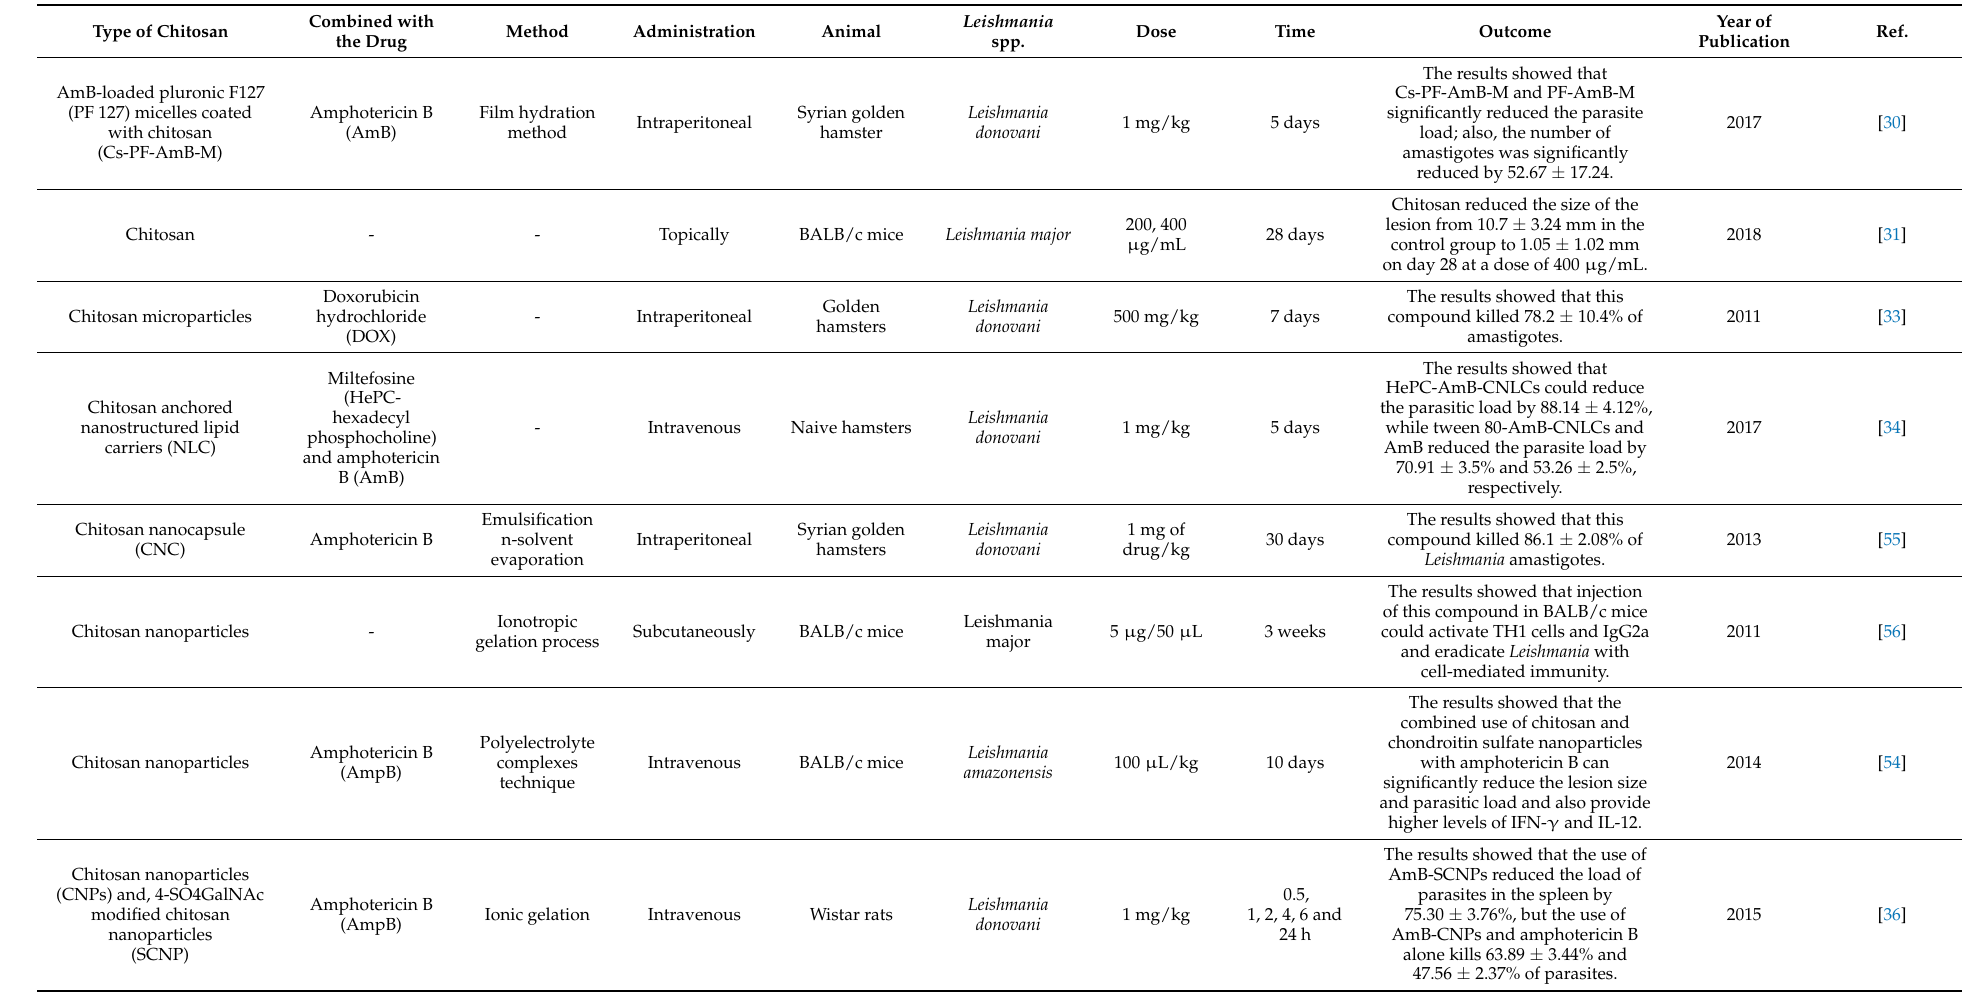
Table 2. A list of in vivo studies of chitosan and its derivatives as resources for anti-leishmanial agents.